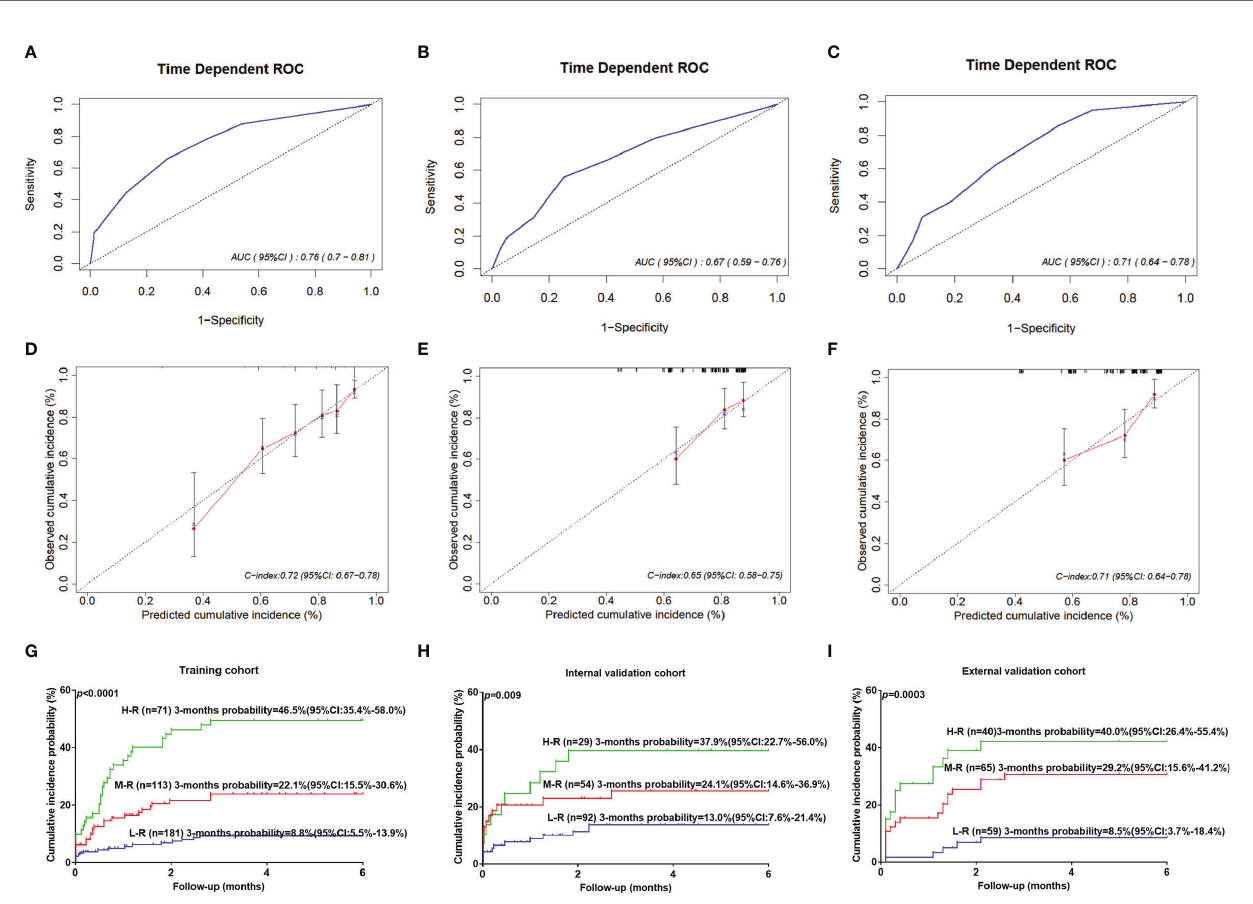
FIGURE 3 | The performance of IRMM to predict early grade ≥ 3 infection during the fi rst 3 months of MM diagnosis. Time-dependent ROC curves and AUCs at 3 months to assess the prediction accuracy of IRMM in the training cohort (A) , internal validation cohort (B) , and external validation cohort (C) . Calibration curves of the IRMM in the training cohort (D) , internal validation cohort (E) , and external validation cohort (F) . Time to infection in the fi rst 3 months for high-, moderate- and low-risk groups in the training cohort (G) , internal validation cohort (H) , and external validation cohort (I) . AUC, area under the curve; H-R, High risk; L-R, Low risk; M-R, Moderate risk; ROC, receiver operating